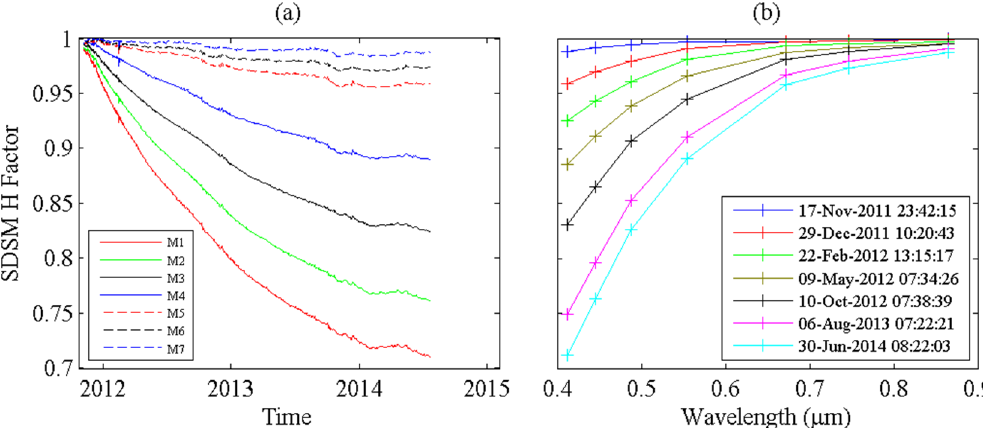
Figure 3. ( a ) VIIRS SD degradation over time as revealed by H factor for M1–M7 band; and ( b ) spectral dependence of VIIRS SD reflectance change over time. dependence of VIIRS SD reflectance change over